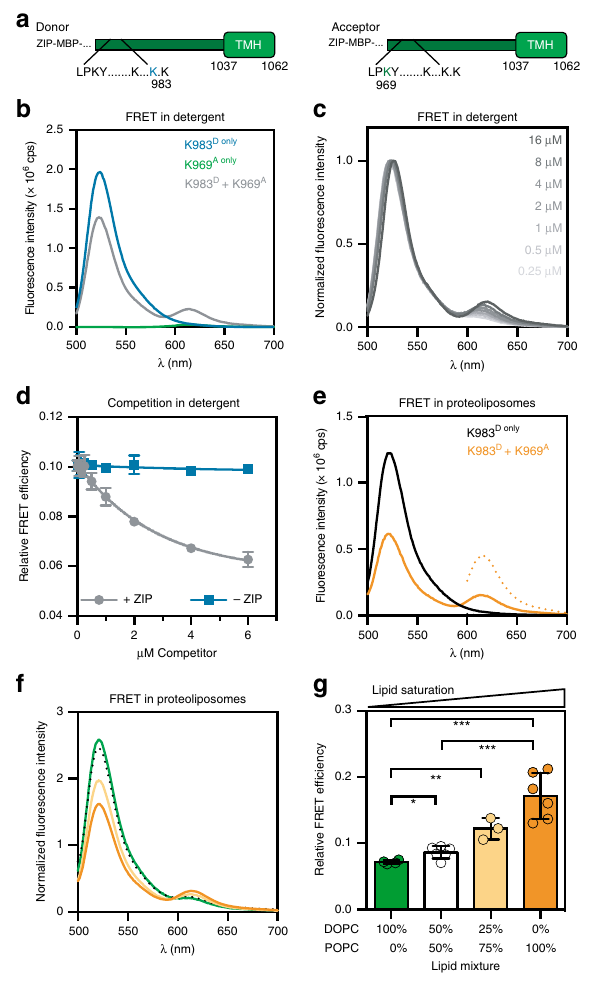
(Fig. 3f, g). At higher proportions of saturated lipid acyl chains in the bilayer, the FRET ef fi ciency increased. These data demon- strate that the acyl chain composition in the hydrophobic core of the membrane imposes structural changes to regions outside the membrane, which have been implicated in signal propagation 35,41 . Our data establish an intricate functional and structural coupling between the TMH regions and the sites of ubiquitylation.